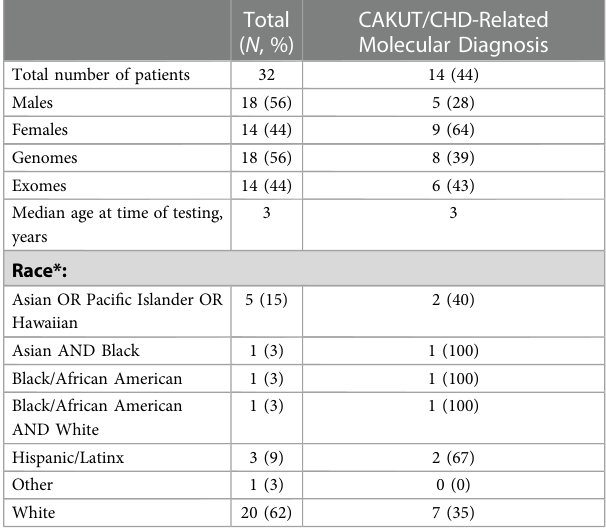
TABLE 1 Study population